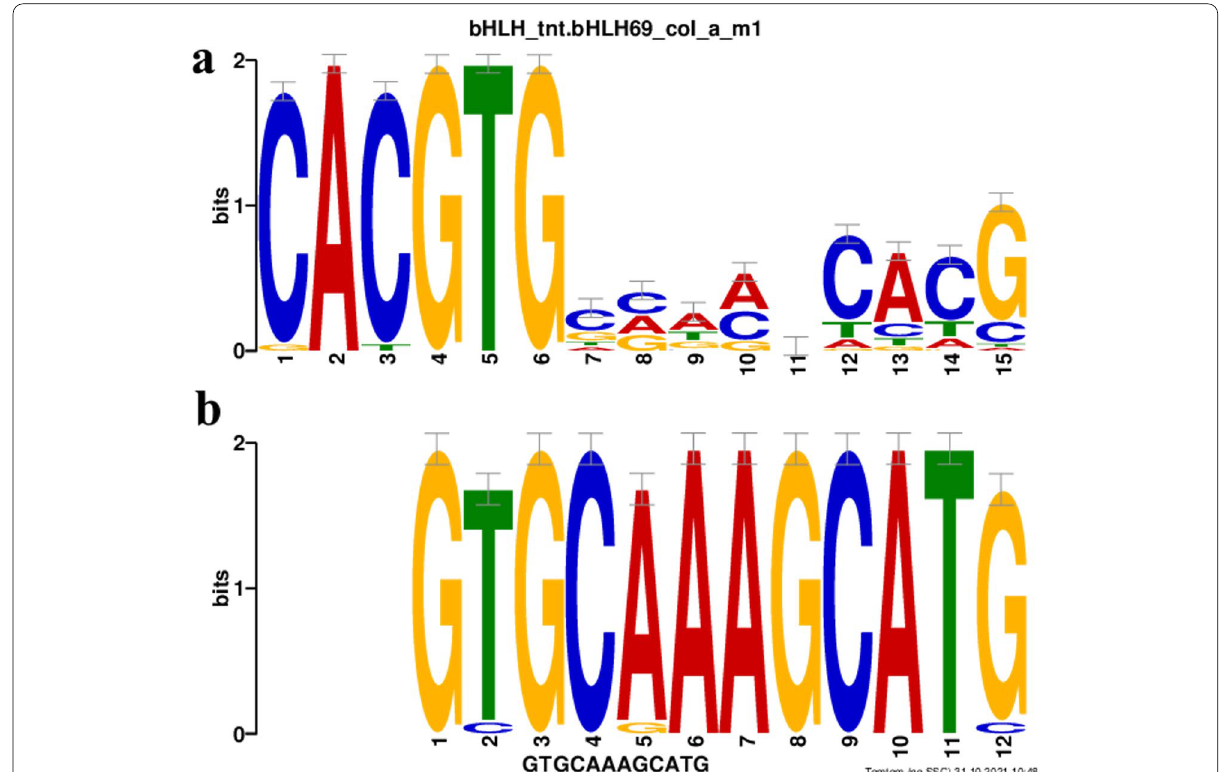
Fig. 3 The sequence-logo comparison of conserved motifs between a Arabidopsis thaliana bHLH69 and b the motif found in putative phytochrome A genes